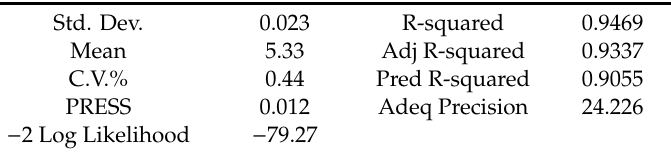
Table 9. Predicted R-square vs. adjusted R-square.